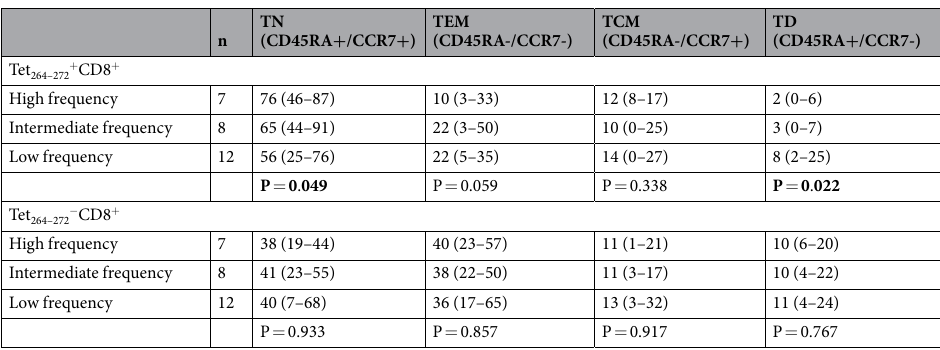
Table 3. Association of phenotypes a of wt p53-specific tet 264–272 + CD8 + or tet 264–272 − CD8 + T cells with frequencies (n = 27). a The data are median percentages of positive cells among all tet + CD8 + T cells or all tet − CD8 − T cells with the ranges in